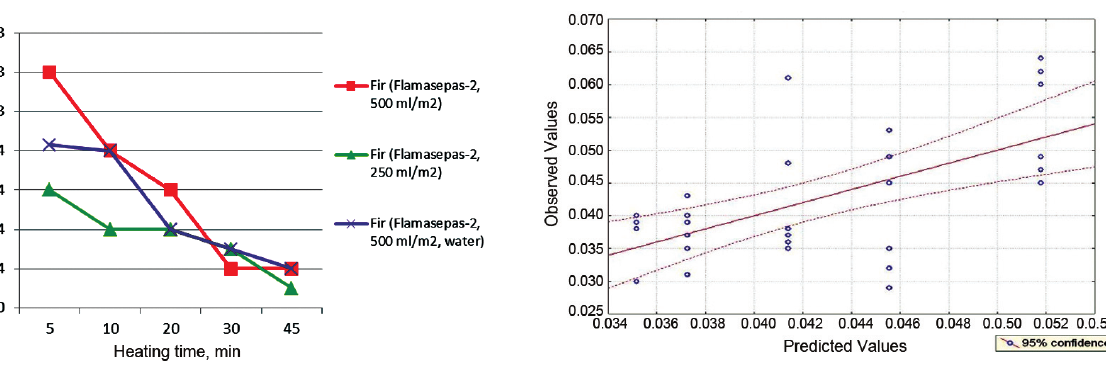
fig. 13. the observed and predicted electrical capacitance values of natural wood